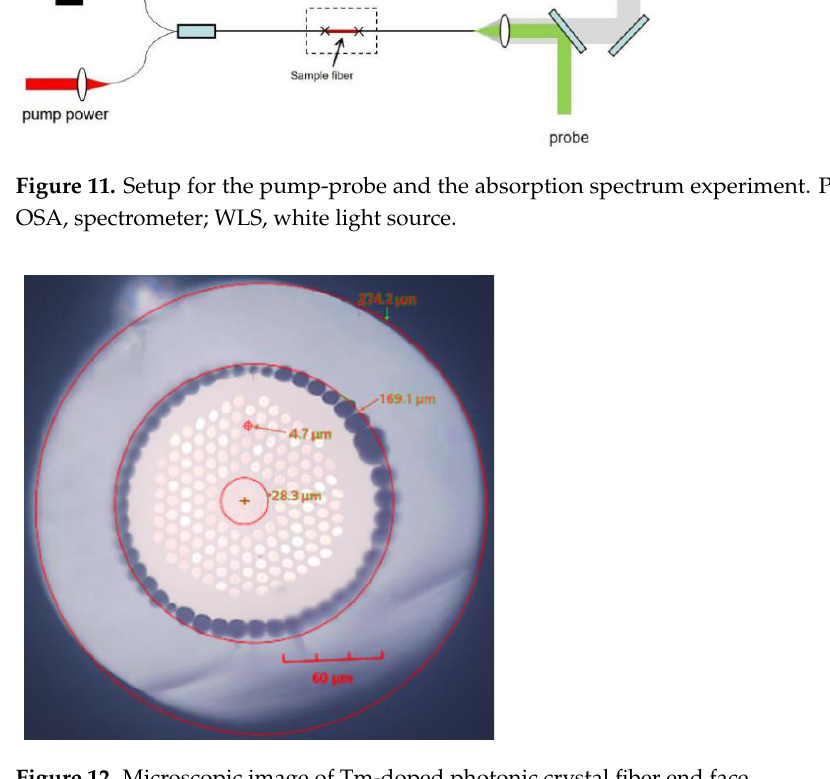
Figure 12. Microscopic image of Tm-doped photonic crystal fiber end face. Through the experimental device, we obtained the curve of additional loss with time under different power levels (Figure 13) and fit it with Formula (11).